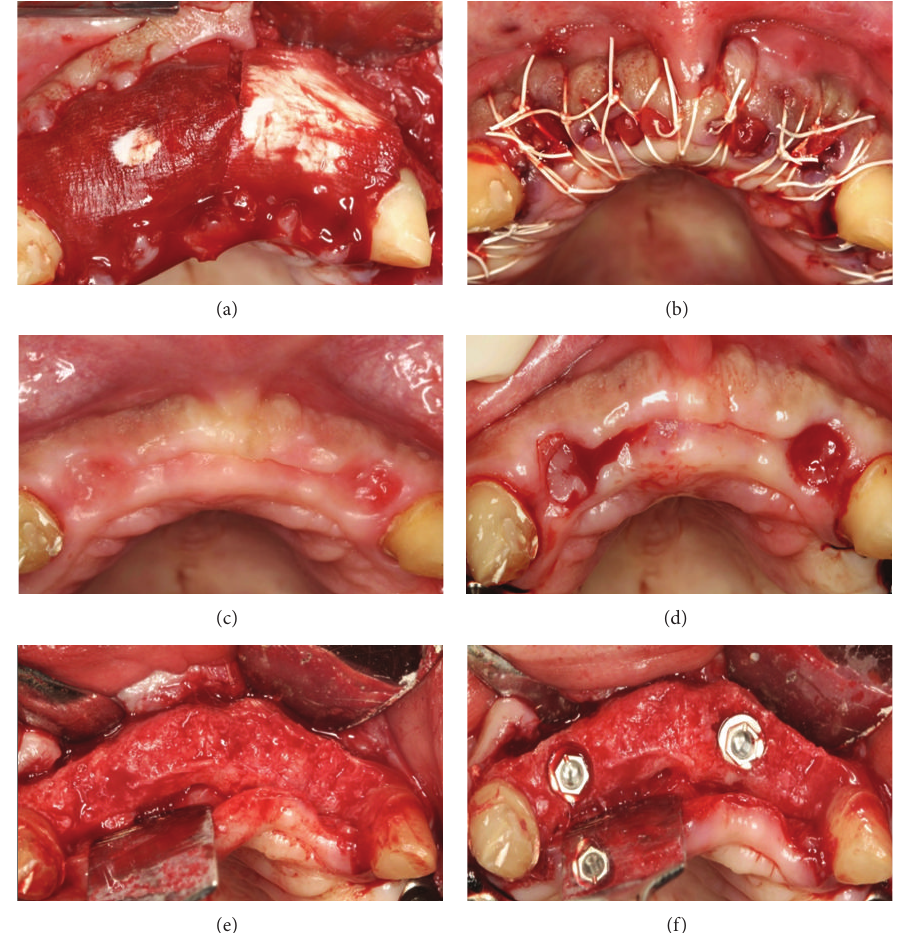
Figure 6: Clinical views of Case 3. After (a) adaptation of two collagen matrices and (b) suturing, (c) at 6 months, and after (d) soft tissue biopsies, (e) flap elevation, and (f) implant